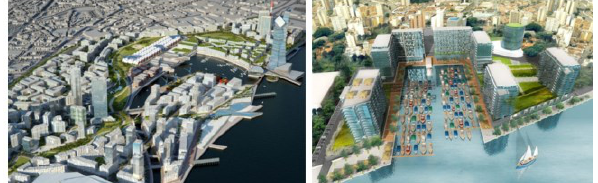
Figure 7. Revitalization of Port Belgrade /Daniel Libeskind& Jan